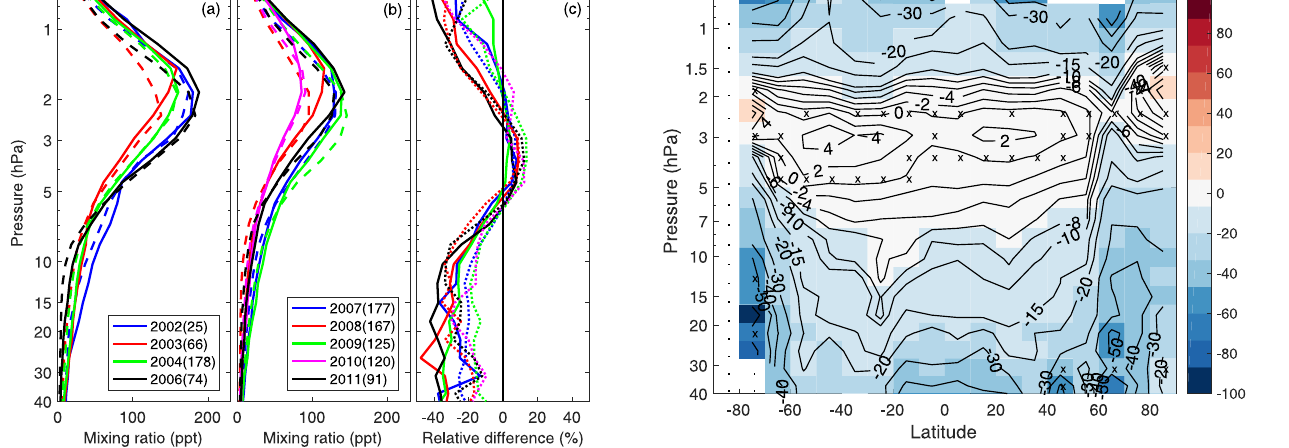
Figure 14. NO 3 yearly median mixing ratio profiles and me- dian relative differences from GOMOS Sirius occultations and from paired WACCM profiles from 2002 to 2011 in the latitude band 40–60 ◦ S. Occultations take place during late August to mid- September. The vertical axis is pressure. (a, b) GOMOS profiles (solid lines) and WACCM profiles (dashed lines). The colour cod- ing in the legend shows the measurement year and the number of measurements is in parentheses. (c) Relative median difference WACCM–GOMOS/median(GOMOS). The colour coding for (c) follows (a, b) , but 2007–2011 lines are dotted.